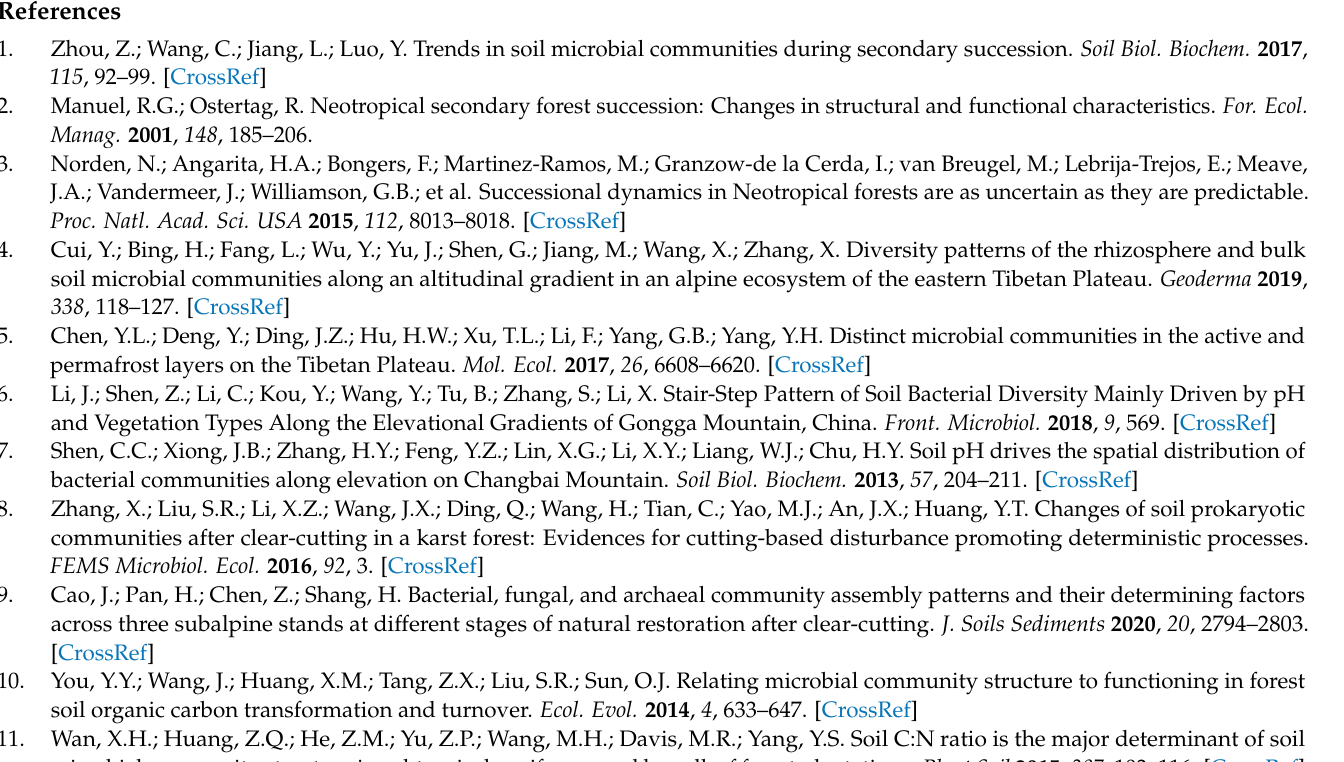
rehabilitation stages. Table S1: The plot characteristics of the four successional stages in a Miyaluo region of Sichuan. Table S2: The bacterial communities in the different rehabilitation stages at different Phylum levels (a), Class levels (b) and Order levels (c). Table S3. The bacterial communities in the different rehabilitation stages at different Class levels. Table S4. The bacterial communities in the different rehabilitation stages at different Order levels. Table S5: Mantel test showing the effects of rehabilitation stage and soil factors on bacteria community structure. Table S6: Relative importance of the significant independent variables explaining the variance in abundance of the different taxonomic groups. Table S7: ANOVA analysis (Simple effect) explaining the explanatory value of single factors on the change of soil bacterial